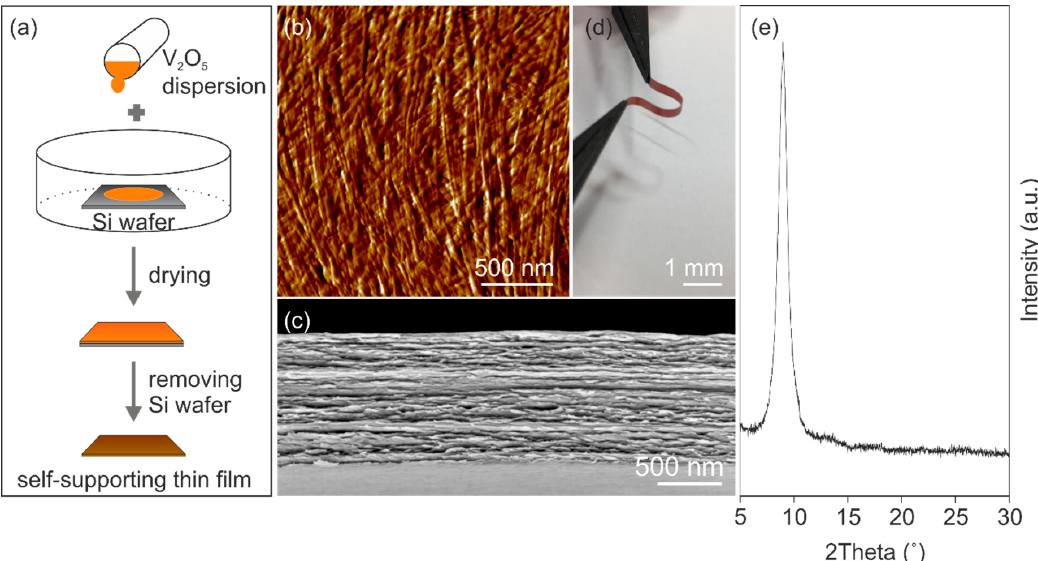
Figure 1. ( a ) Schematic illustration of vanadium pentoxide (V 2 O 5 ) thin film preparation. A Si wafer is placed in a beaker that is filled up with the V 2 O 5 dispersion. Drying at ambient conditions and removing the Si wafer from the V 2 O 5 thin film results in the self ‐ supporting V 2 O 5 paper ‐ like thin film. ( b ) AFM image of the paper ‐ like surface showing the nanofiber alignment. ( c ) SEM image of the V 2 O 5 paper revealing a layered structure. ( d ) Shaped V 2 O 5 paper showing the flexibility. ( e ) XRD pattern of the V 2 O 5